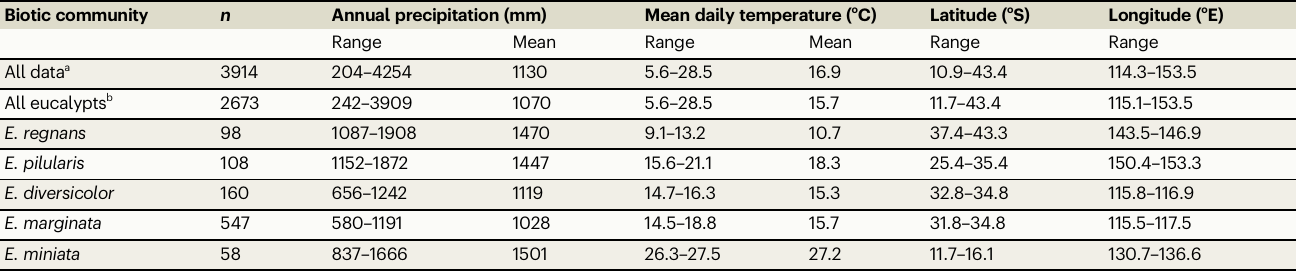
Table1|Summaryofclimate, locationandsamplesizefor litterdatafromallAustralianforestsandwoodlands,for alleucalypt- dominated forest and woodlands, and for fi ve representative communities Biotic